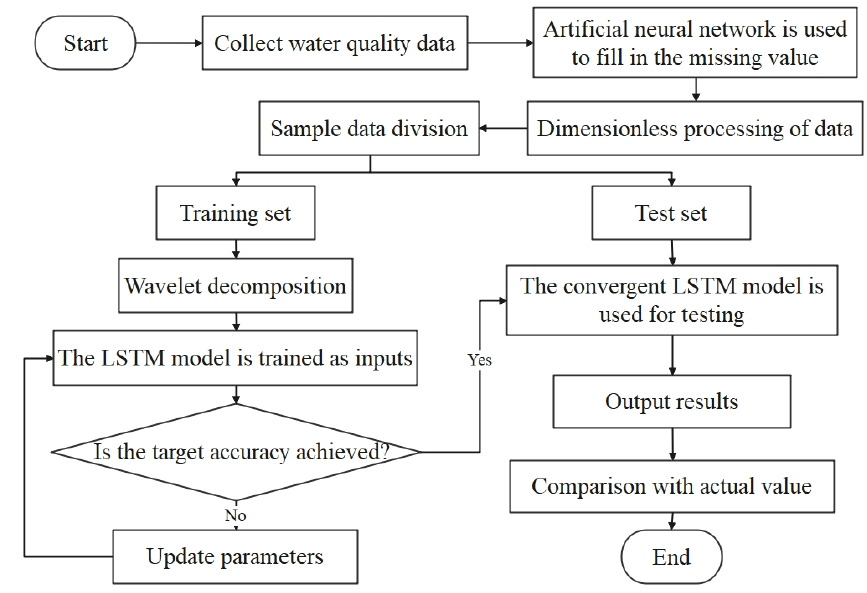
Figure 3. Flow chart of water quality prediction model.